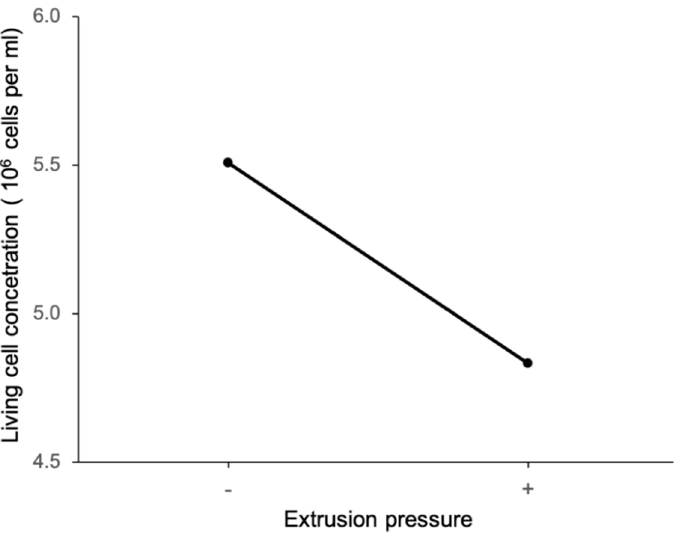
Figure 11. Main effect of extrusion pressure on living cell concentration.